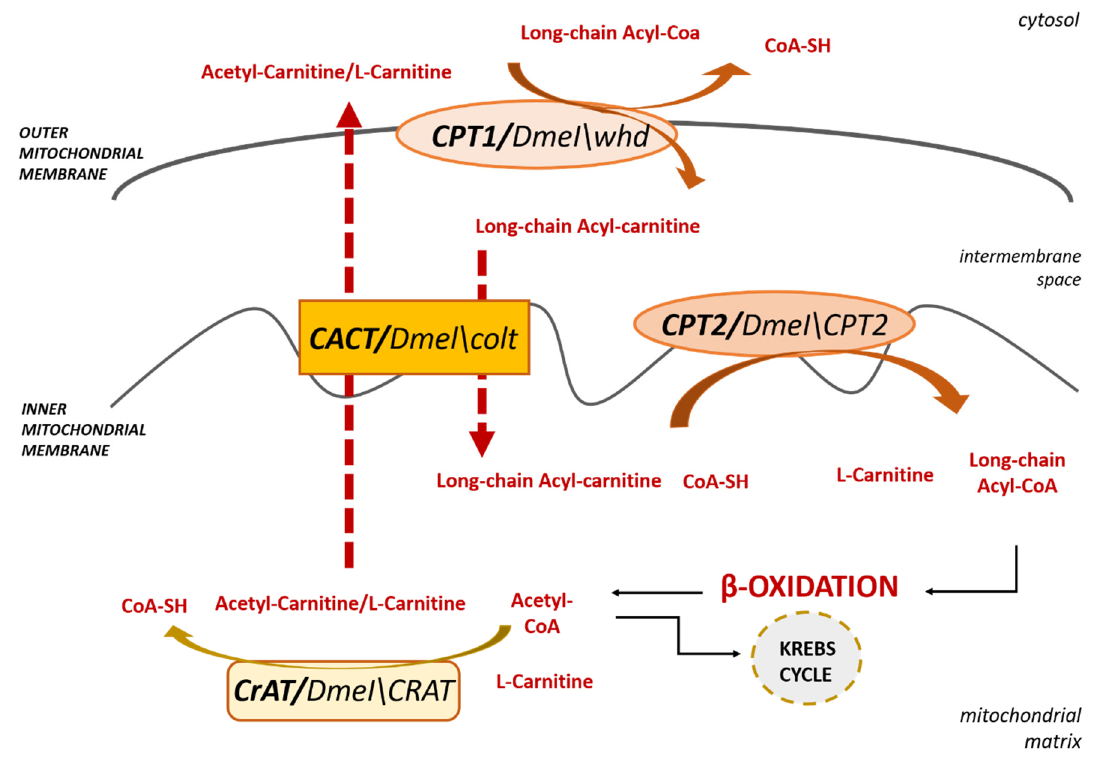
Figure 2. An overview of the Carnitine Shuttle. The Drosophila orthologs are reported near each enzyme with their Dmel name.